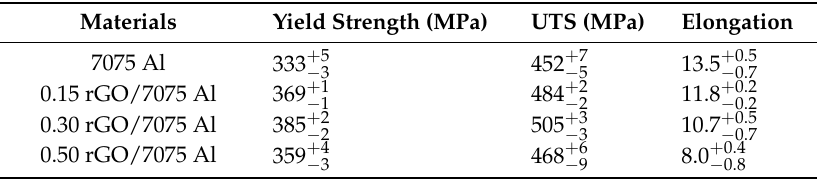
Table 3. Tensile properties of 7075 Al and rGO/7075 Al composites.